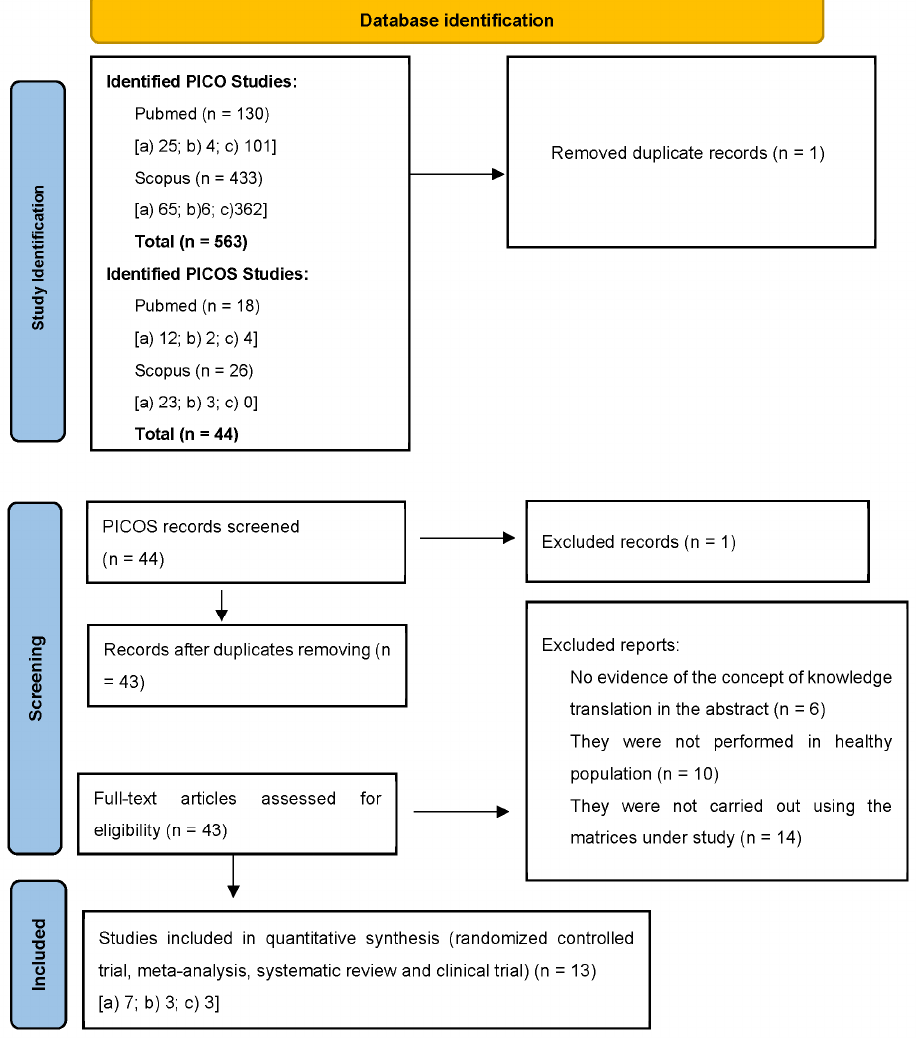
Figure 1. PRISMA 2020 flowchart of the search strategy on grape, grape by-products polyphenols, gut microbiota, and health [22].